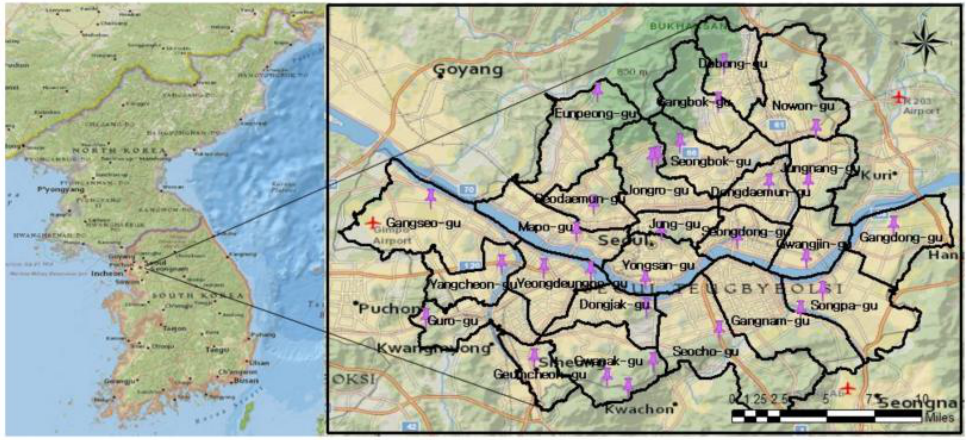
Figure 1. Location of the study area (City of Seoul). The total area is about 605.21 km 2 and the population of the city is 9.8 million.